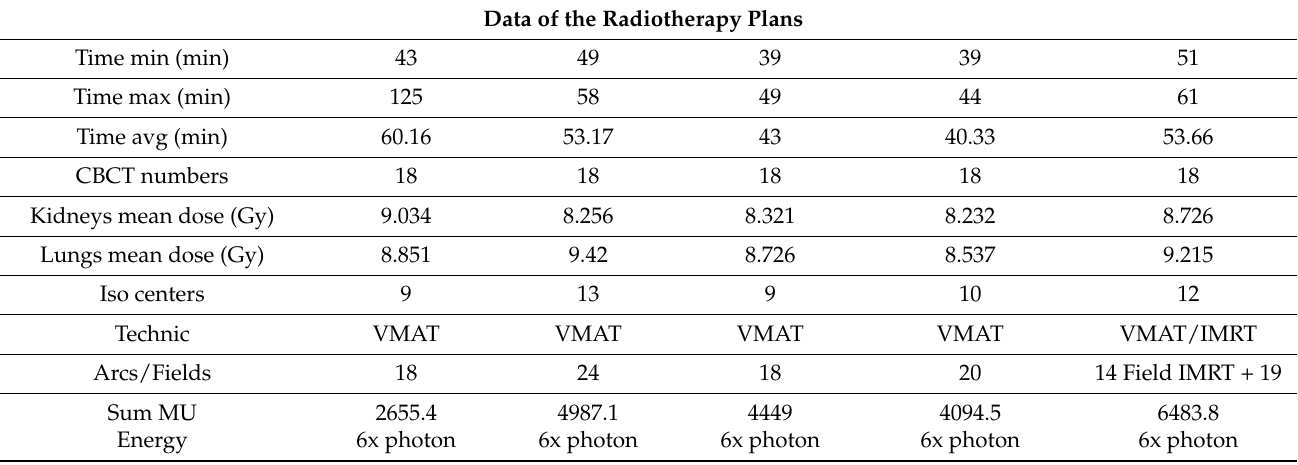
Table 2. Data of the radiotherapy plans (CBCT: cone-beam computed tomography, Gy: Gray,